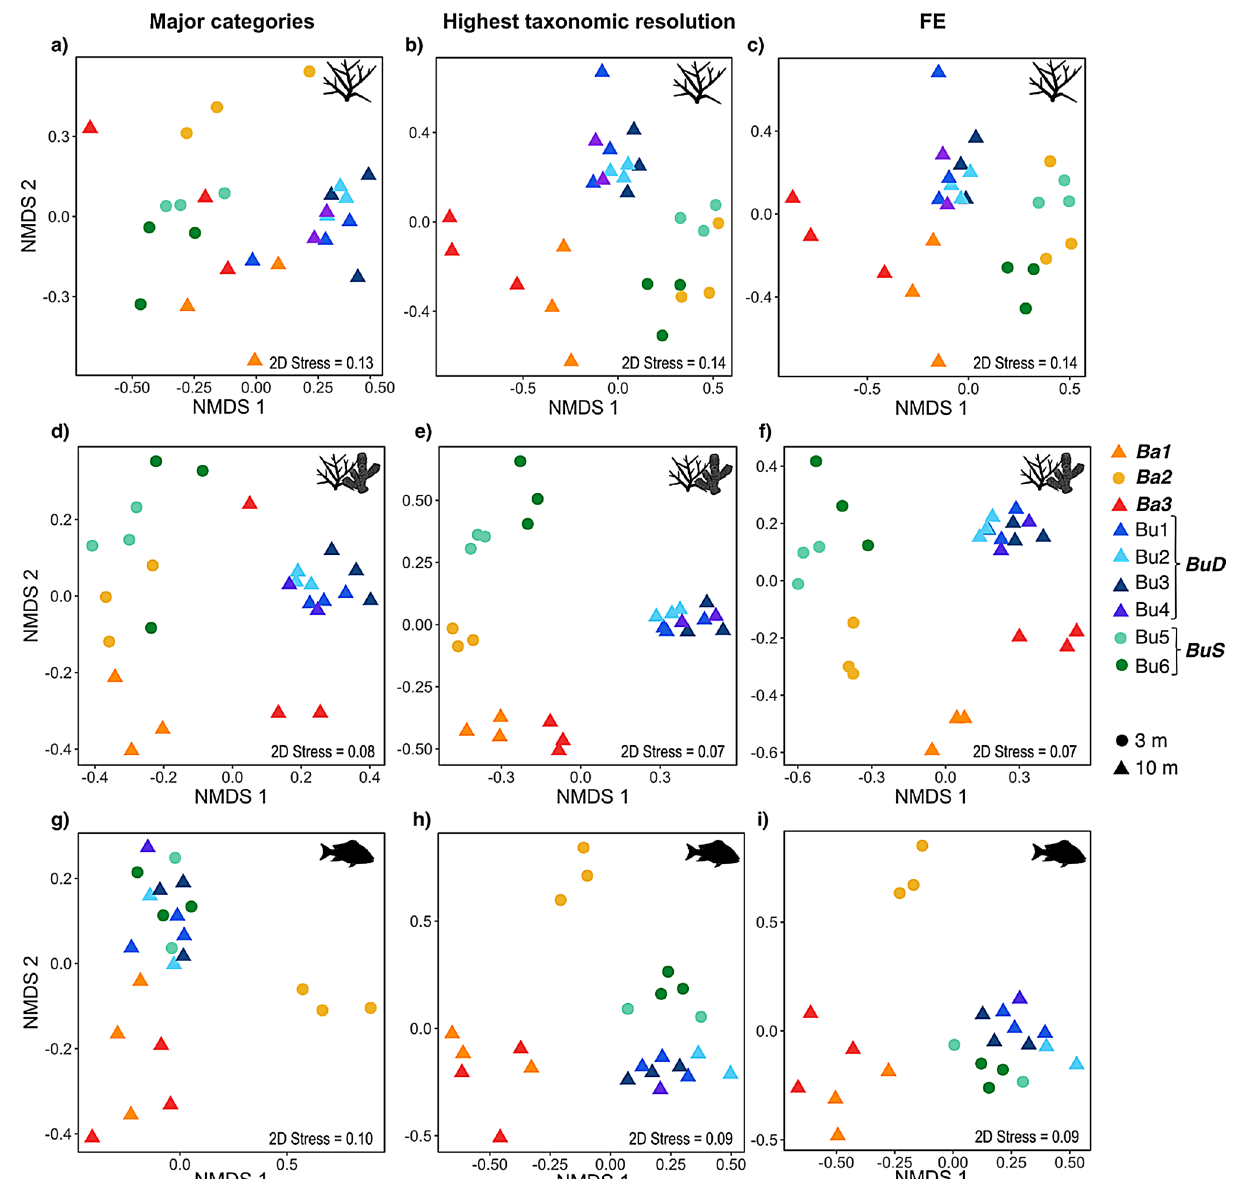
Figure 2. Analysis of the benthos [only scleractinian corals ( a – c ) and all benthic organisms ( d – f )] and fish ( g – i ) community similarities (nMDS based on Euclidean distances) between the different sites samples using three levels of ecological information: major categories, highest taxonomic resolution and functional entities (FE). Community regimes of sites grouping together are highlighted in bold and italics (Ba1, Ba2, Ba3, BuD and